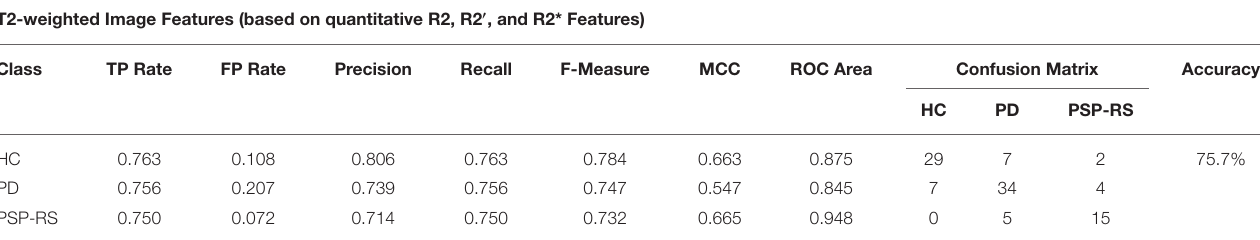
TABLE 4 | Confusion matrix following a PCA + LMT classification combination using brain iron content measures only. T2-weighted Image Features (based on quantitative R2, R2 ′ , and R2*